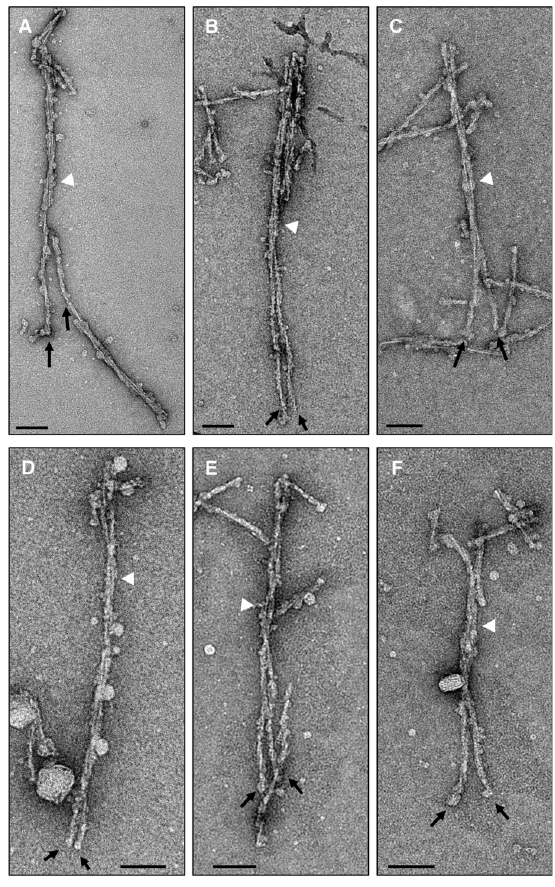
Fig 4. Side-by-side comparisons of the one- and two-protofilament fibrils. ( A-F ) Negative stain electron micrographs showing the two distinct morphologies of L-type BSE fibrils side-by-side. ( A ) A negative-stained electron micrograph showing a long, isolated fibril composed of two protofilaments (white arrowhead), which appears to be broken and split into two one-protofilament fibrils towards its lower end (black arrows). ( B-F ) L-type BSE amyloid fibrils showing a two-protofilament fibril at one end (white arrowheads) and two one-protofilament fibrils at the other end (black arrows). Scale bar = 100